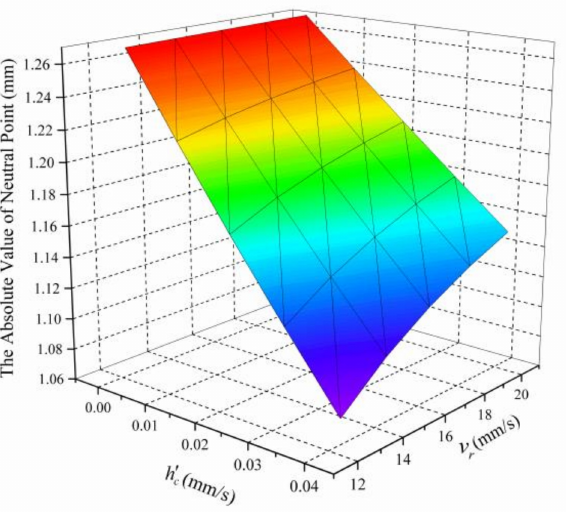
Figure 14. The influence of roll gap reduction velocity and rolling velocity on the position of neutral point (2 h 1 = 1.816 mm).